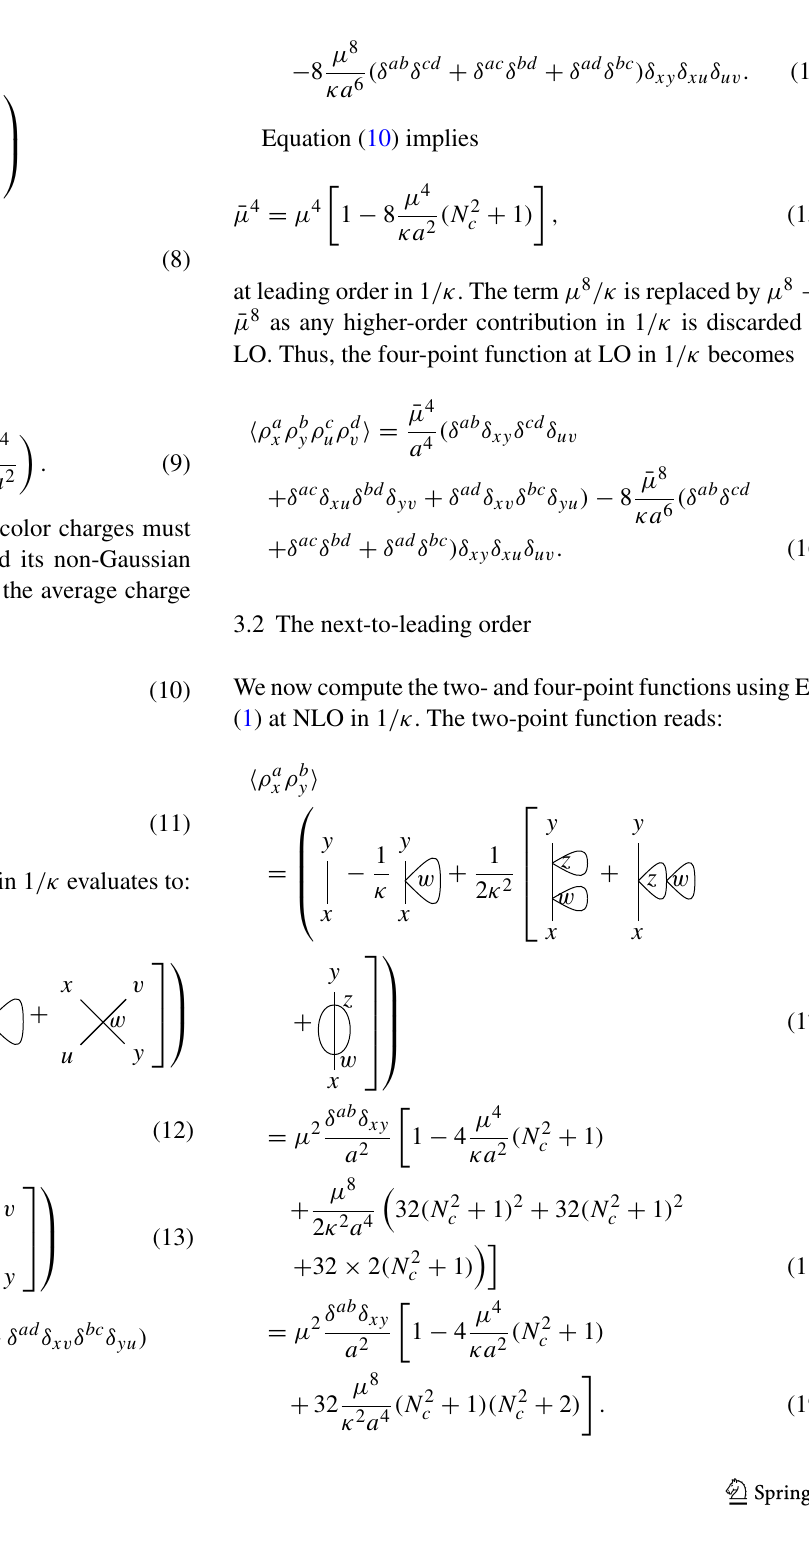
Fig. 1 The color factor for diagrams contributing at LO for the two- and four-point function of color